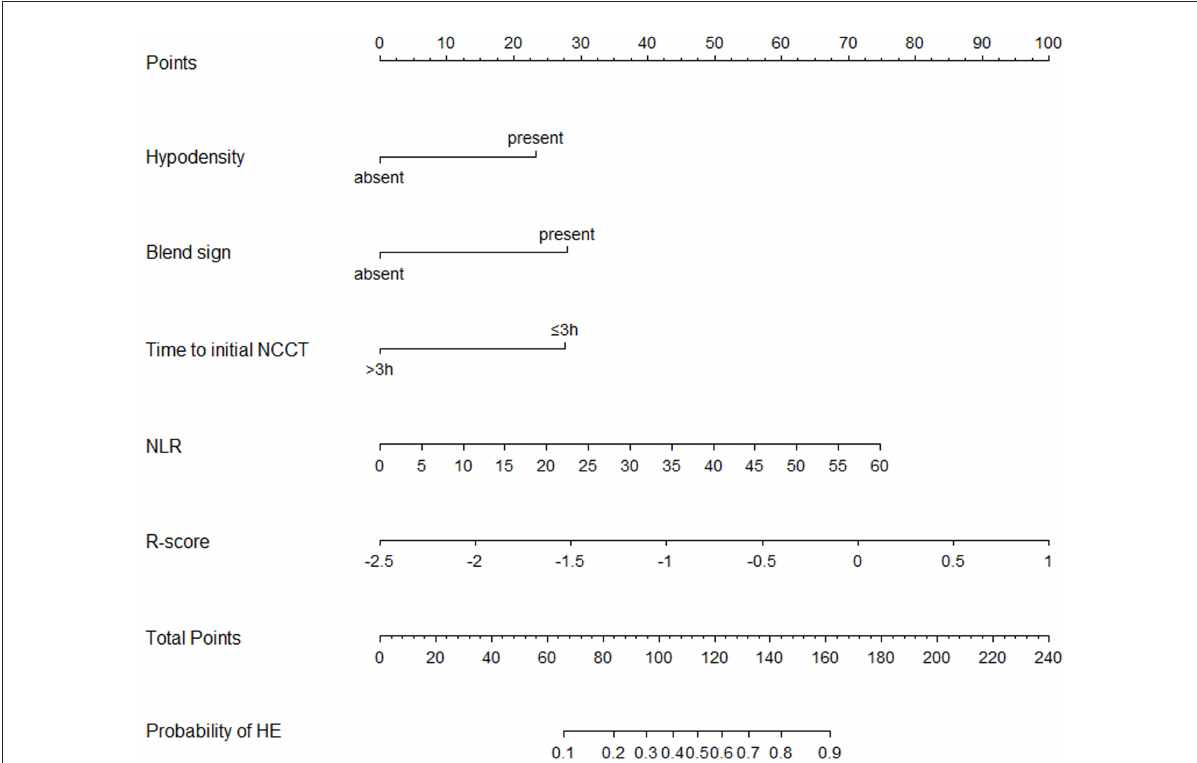
FIGURE5 Nomogram for predicting the probability of HE was developed based on the combined model. Points were assigned for hypodensity, blend sign, time to initial NCCT, NLR, and R-score by drawing a line upward from the corresponding values to the “points line.” The “total points” are calculated as the sum of the individual score of each of the five variables included in the nomogram. The risk of HE was determined by drawing a vertical line from the total point axis to the lowest line of the nomogram. NCCT, non-contrast computed tomography; NLR, Neutrophil to lymphocyte ratio; HE, hematoma expansion.